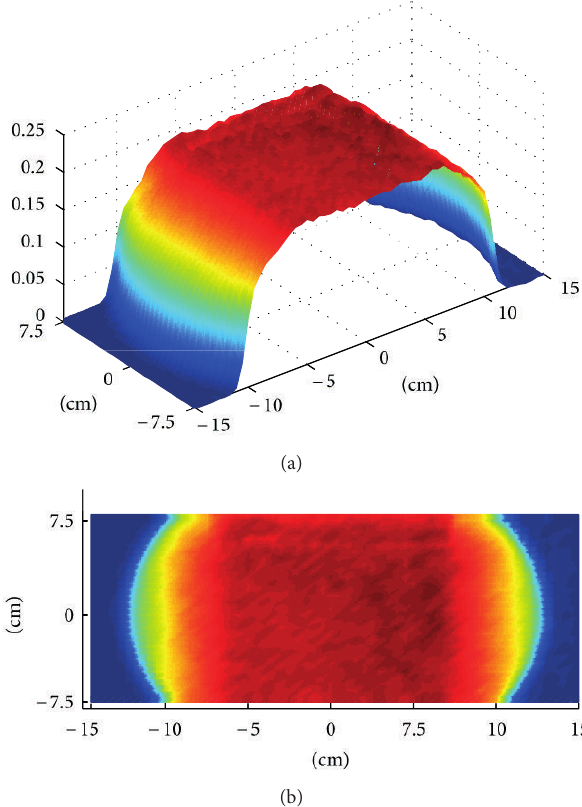
Figure 9: Measurement of the L 1- L 2 beam for 𝛼 = 15 ∘ : 3D and 2D